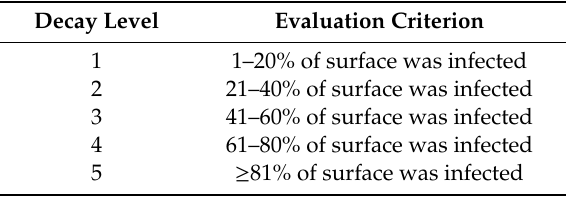
Table 1. Decay rate